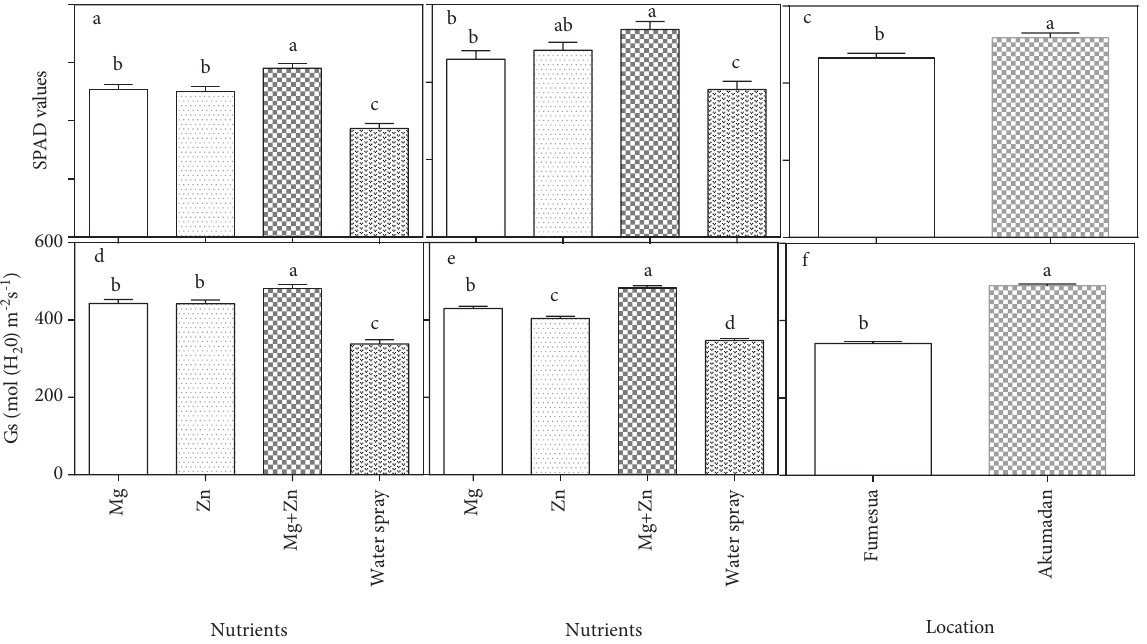
Figure 2: Impact of treatment on chlorophyll content at vegetative (a) and flowering (b) stages and stomatal conductance at vegetative (d) and flowering (e) stages at different locations. Bars with different letters in the figure are statistically different at P < 0 . 05. Error bars represent the standard error of means. Means comparison was done using Tukey HSD (honestly significant difference) ( P < 0 .